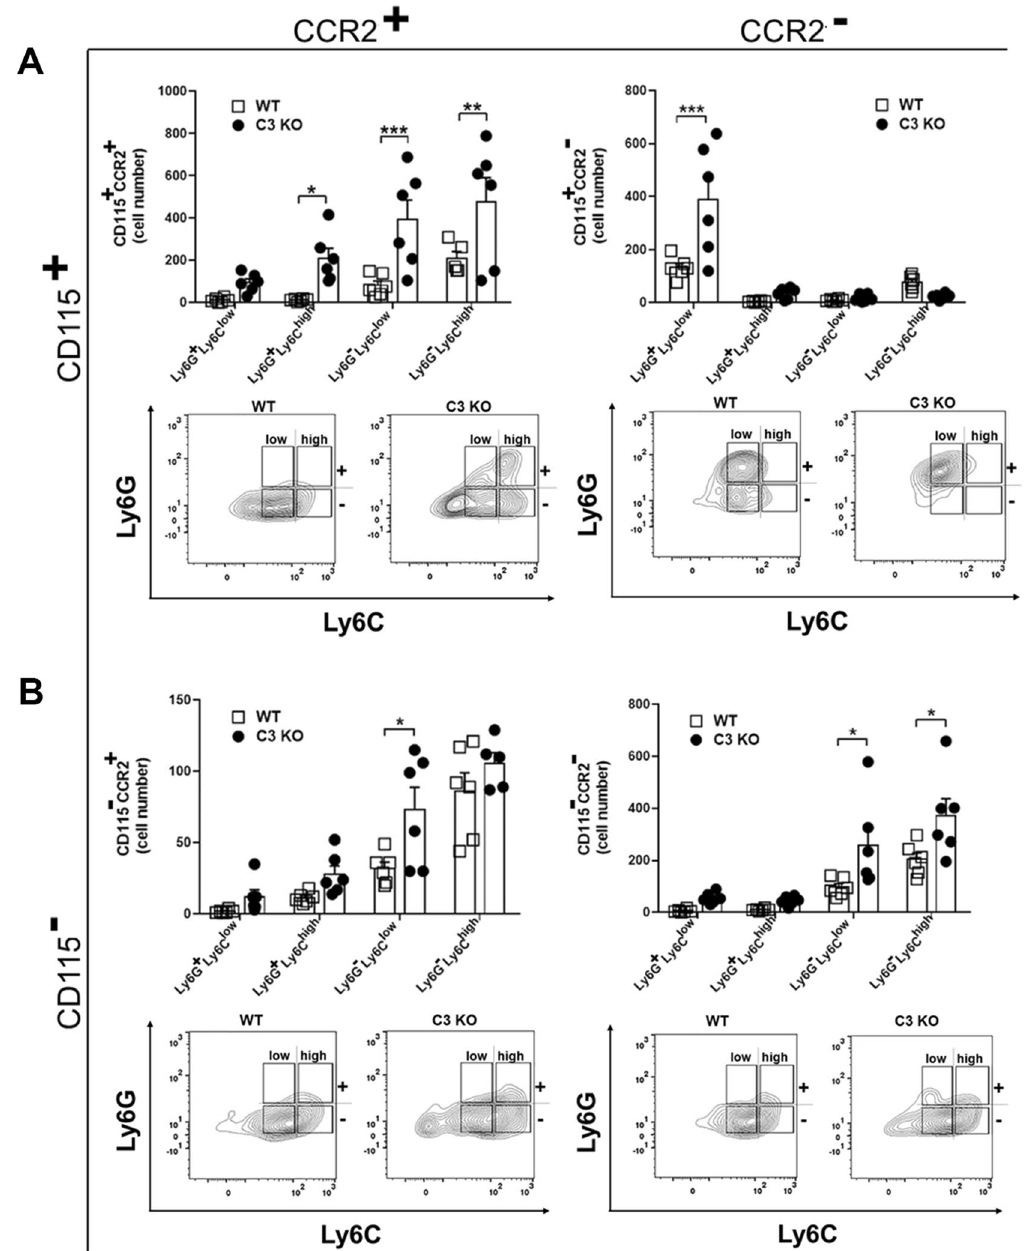
Figure 5. Multiple myeloid-derived cell populations are elevated in the cornea of C3 KO mice at day 7 post infection. HSV-1 infected C3 KO and WT mice were euthanized by exsanguination at 7 days pi, and the corneas were removed and enzymatically processed to single cell suspensions. ( A ) Absolute number of CD45 + CD11b + CD115 + Ly6G and Ly6C myeloid cell subpopulations that do or do not express CCR2. Panels below are representative flow plots of cell distribution in terms of high- and low-expressing Ly6G and Ly6C phenotypes. ( B ) Absolute number of CD45 + CD11b + CD115 − Ly6G and Ly6C myeloid cell subpopulations that do or do not express CCR2. Panels below are representative flow plots of cell distribution in terms of high- and low-expressing Ly6G and Ly6C phenotypes. *** p < 0.001, ** p < 0.01, and * p < 0.05 comparing the C3 KO to WT mouse indicated phenotypes of granulocytes/neutrophils, inflammatory monocytes, and macrophages as determined by unpaired, two-tail t -test. The results displayed are from two independent